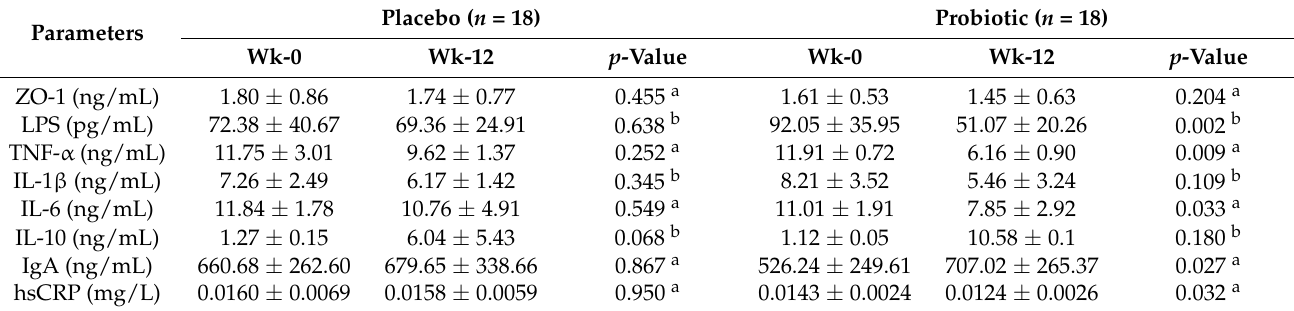
Table 4. Blood levels of ZO-1 and inflammation parameters at baseline and at the end of the study.